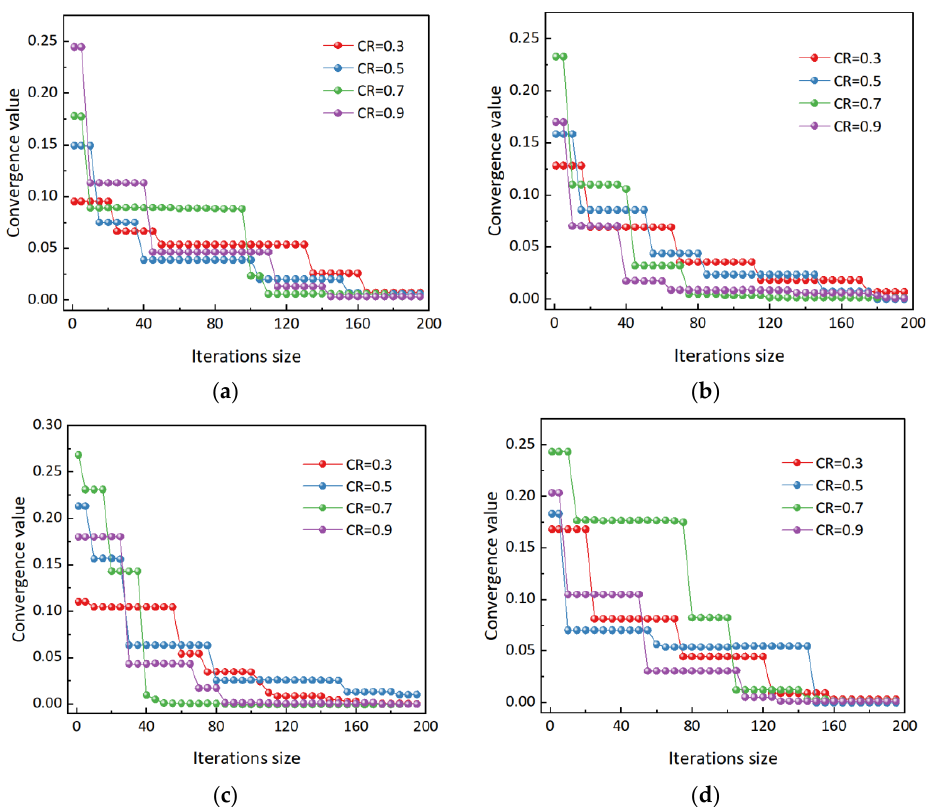
Figure 13. Training convergence curve under different F and CR values: ( a ) F = 0.3; ( b ) F = 0.5; ( c ) F = 0.7; ( d ) F = 0.9.